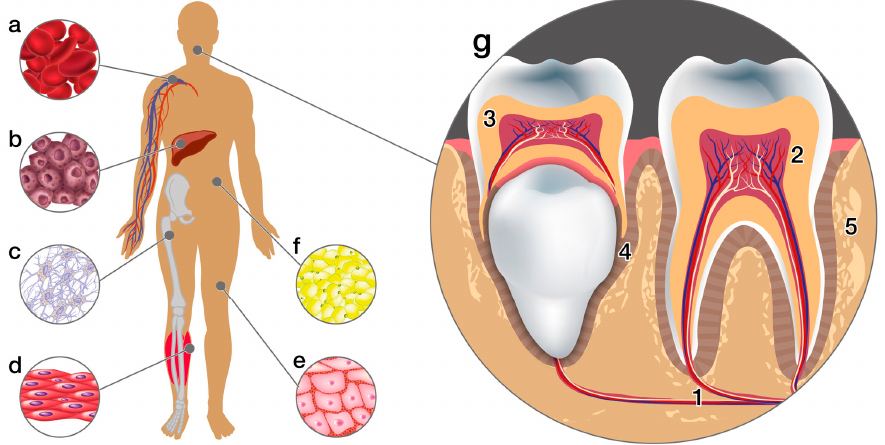
Figure 3. Sources of stem cells in the human organism. The diagram shows some tissue sources of adult stem cells. ( a ) Peripheral blood, ( b ) Liver, ( c ) Bone marrow, ( d ) Muscles, ( e ) Skin, ( f ) Adipose tissue, ( g ) Dental tissues: (1. Apical dental papilla, 2. Adult pulp, 3. Pulp of deciduous teeth, 4. Periodontal ligament, and 5. Alveolar bone).